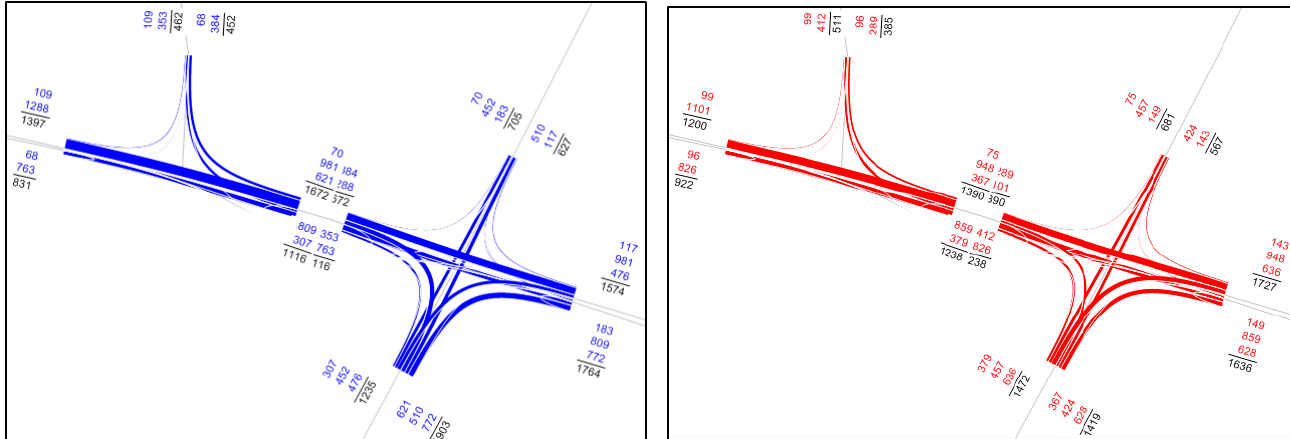
Figure 7. Example of a.m. ( left ) and p.m. ( right ) traffic volumes on a junction as outputs from a simple database.